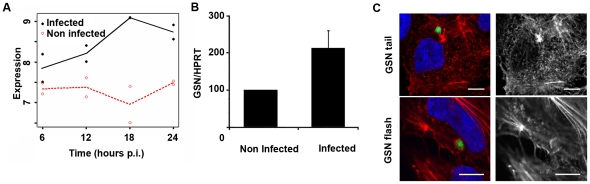
Gelsolin expression and distribution around developing P. berghei.(A) Microarray data of GSN expression levels in P. berghei- infected and non infected Hepa1-6 cells at different time points of infection, from [18] (B) qRT-PCR data of GSN expression in P. berghei infected and non-infected Huh7 cells at 12 hours p.i.. (C) Huh7 cells showing an accumulation of GSN around GFP-Pb in a pattern similar to an actin cloud and tail-like actin cloud (red and grey: anti-GSN antibody, green: GFP-Pb; blue: nuclei). Scale bars represent 10 µm.